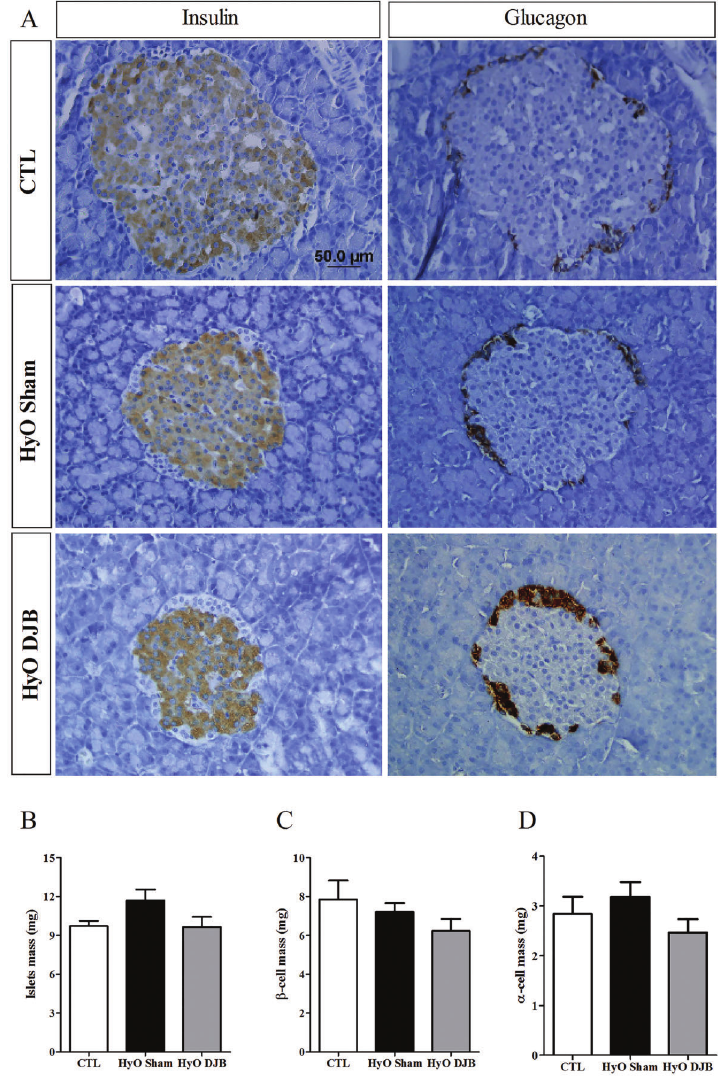
Figure 5. A , Representative images of pancreas sections stained for insulin or glucagon. B , Islet, C , b -cell masses, and D , a -cell masses in the CTL, hypothalamic obese (HyO) Sham and HyO with duodenal-jejunal bypass (DJB) pancreases. Data are reported as means ± SEM (n=3 – 4). P o 0.05, different letters indicate signi fi cant differences (one-way ANOVA followed by the Tukey